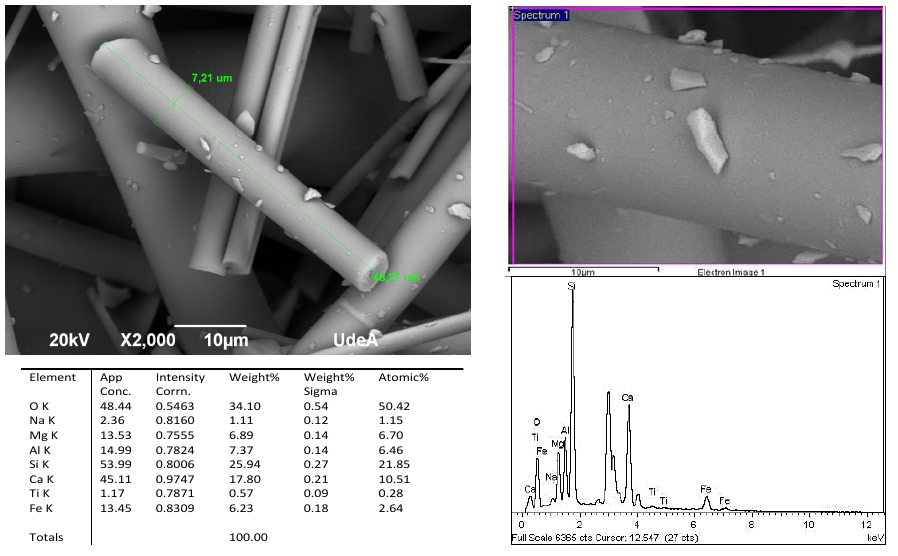
Figure 5. EDS analysis of milled stone wool